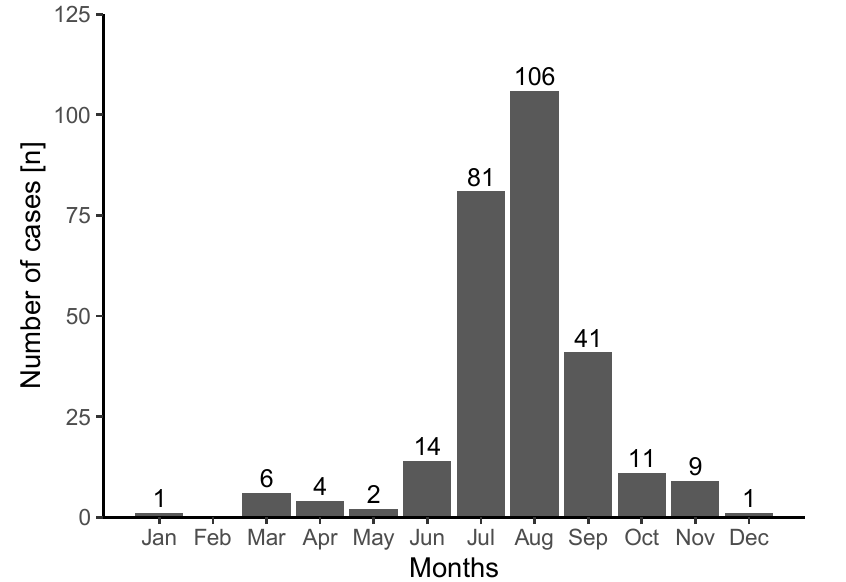
Figure 1. Number of cases due to being lost in the observational period (2009–2020) by month. Color coding: grey, male; black, female.